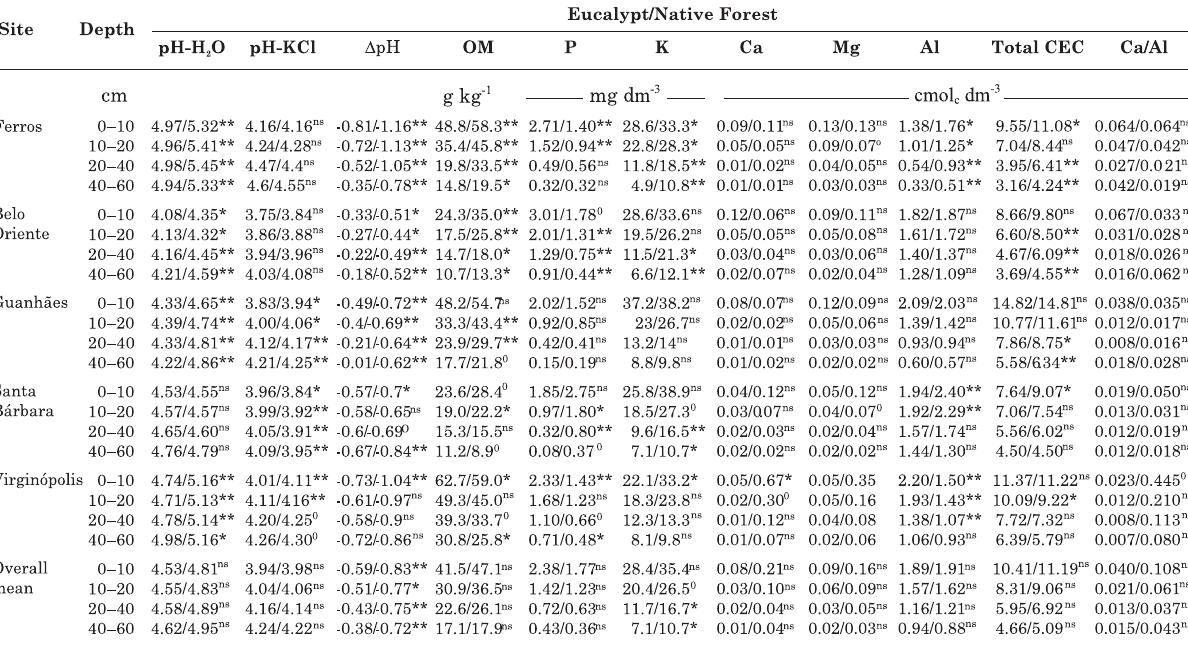
Table 5. Chemical characteristics of soil samples at different depths in areas with eucalyptus/native forest in five areas of the Rio Doce Valley region with their respective significance of the contrast